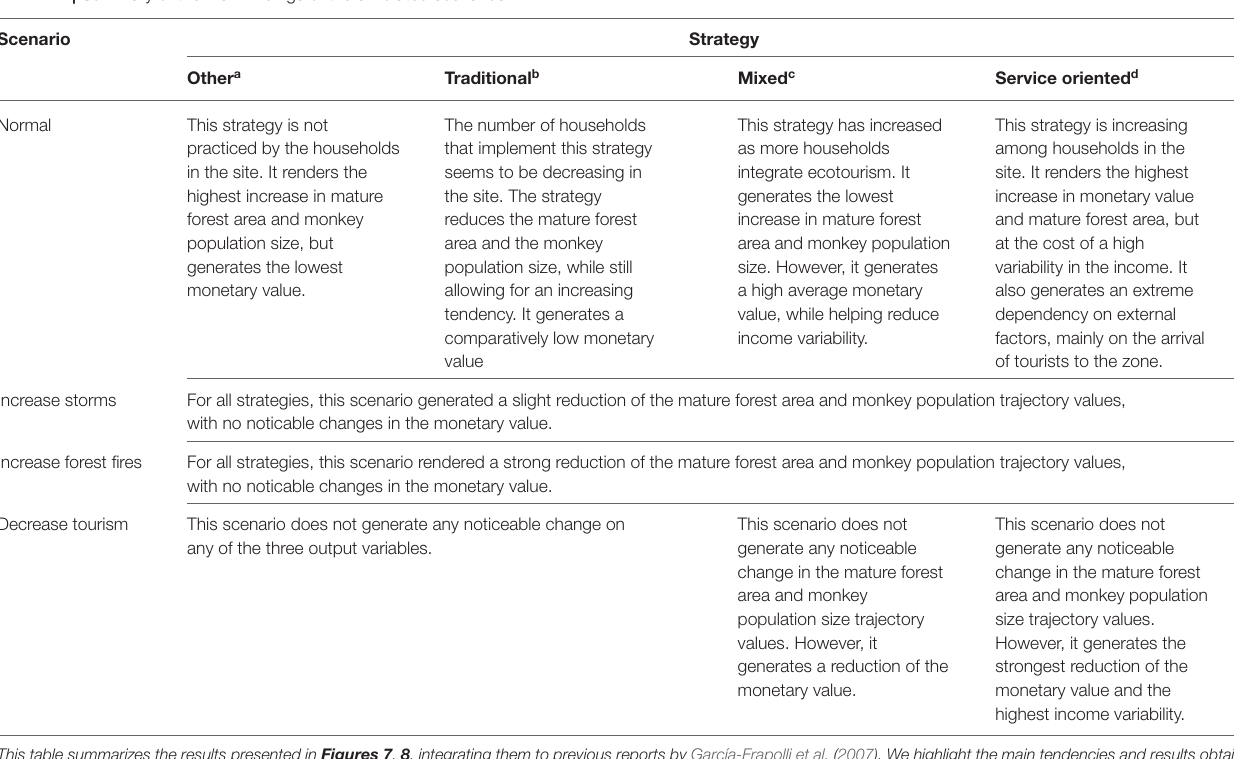
TABLE 1 | Summary of the main findings of the simulated